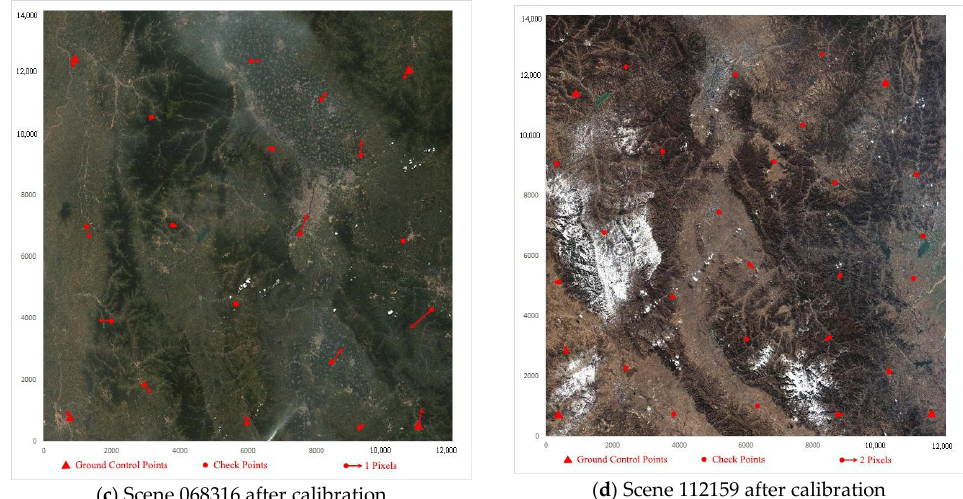
Figure 6. Orientation errors for the stereo mapping images. The red triangles in four corners stand for four ground control points (GCPs) for the affine model (the exterior orientation model). The red points stand for check points (CPs) for orientation accuracy assessment. The longer the red arrow, the more the orientation residual. In ( a , b ), the four corners are more accurate than the middle region. In ( c , d ), the residual errors become less and random due to that the calibration eliminates the nonlinear system error. Thus, the orientation accuracy has been improved after calibration, and the results after orientation can be used to generate the DSM.